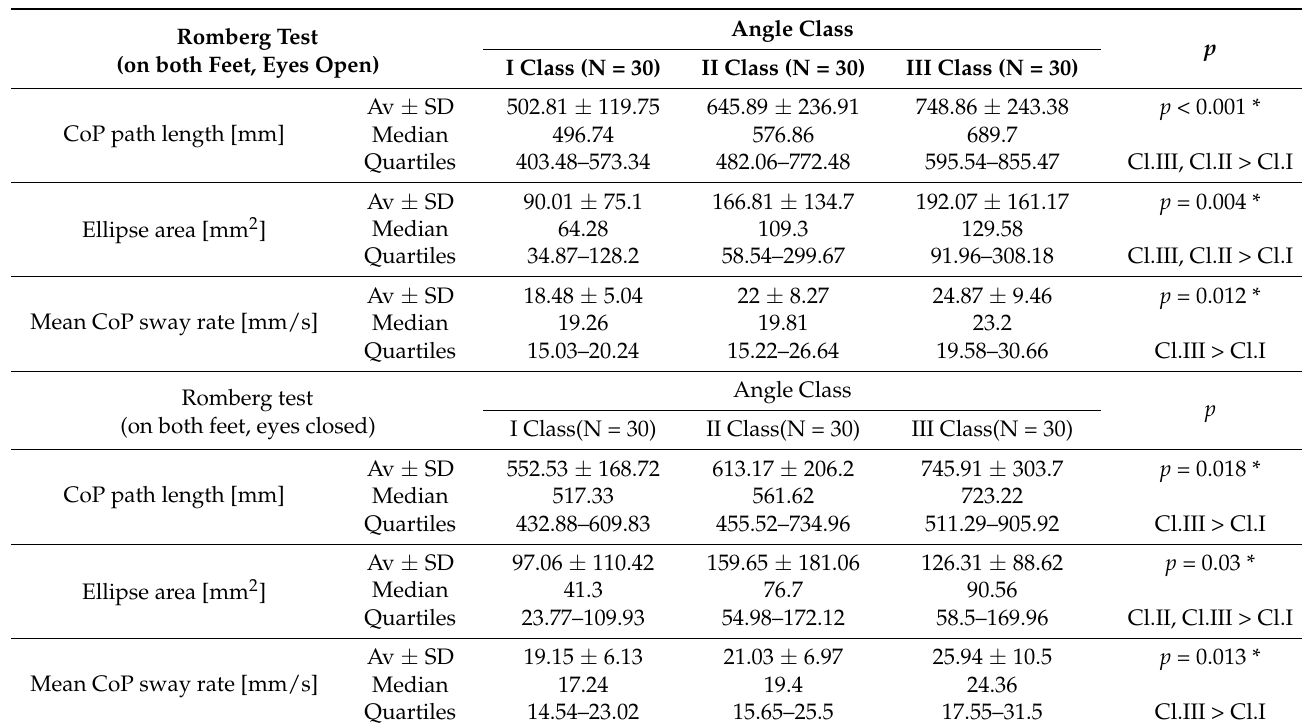
Table 4. The results of selected stabilographic examination